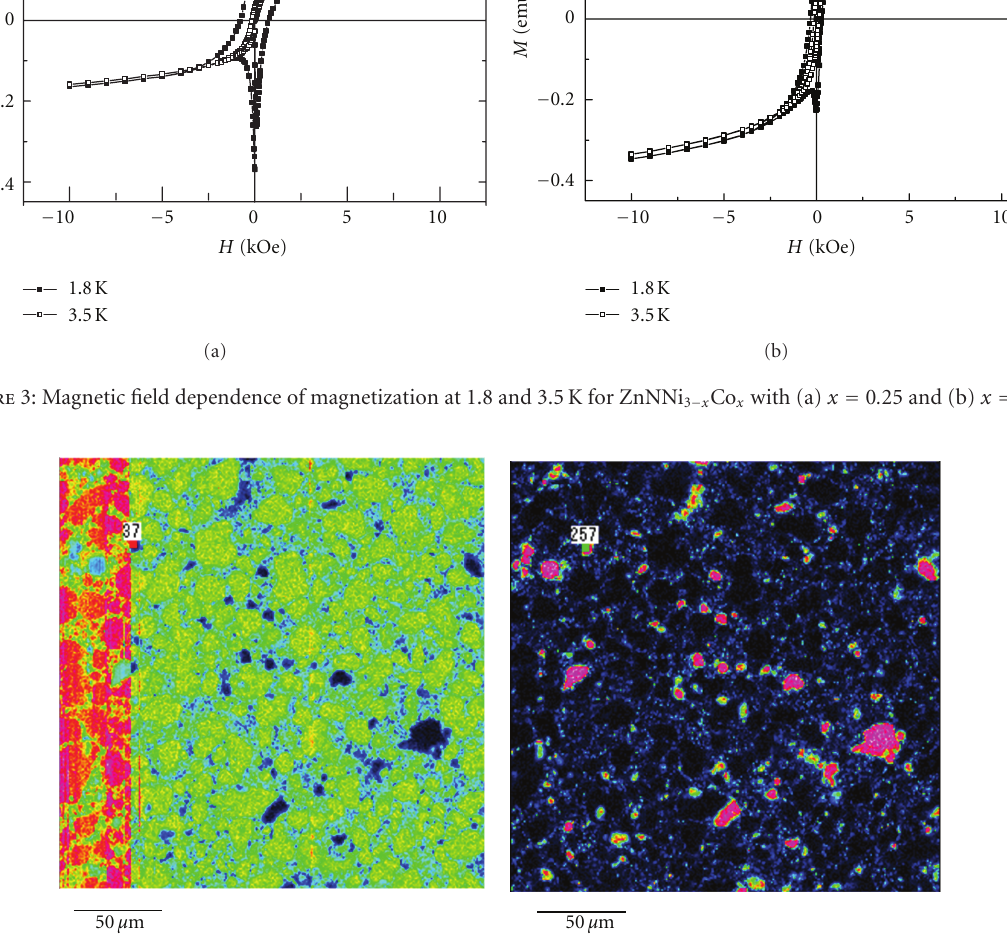
mapping to be about 5%. Except for these ZnN y Ni 0 . 6 Co 2 .